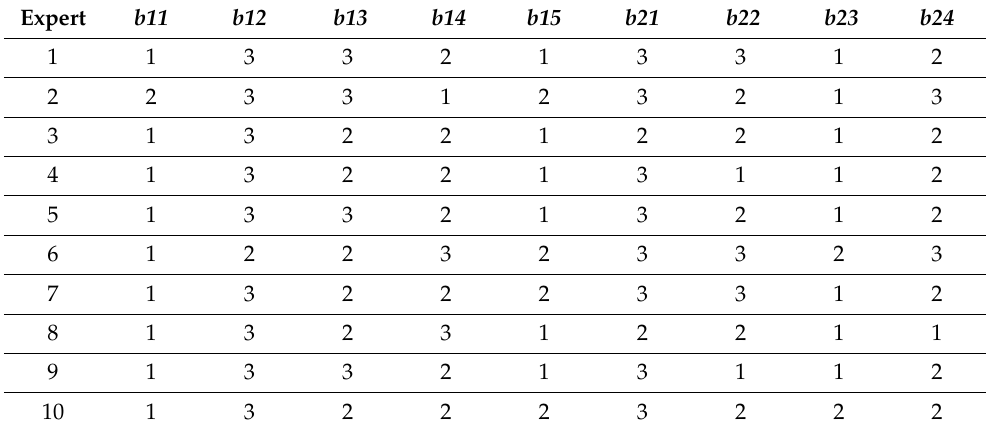
For a given knowledge base K = ( U , T ) , let T be an equivalence relation and r ∈ T . If P ⊆ T ( P (cid:54) = Φ ) , then ∩ P is also an equivalence relation, denoted as ind ( P ) , which is also an indiscernable relation of P . If ind ( T ) = nd ( T − { r } ) , r can be omitted in T ; otherwise, it cannot. According to the rules of rough intensive subtraction: